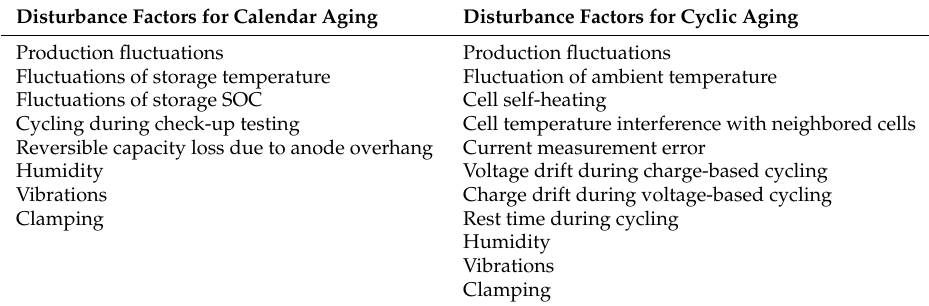
Table 3. Disturbance factors for calendar and cyclic test series on lithium-ion cells